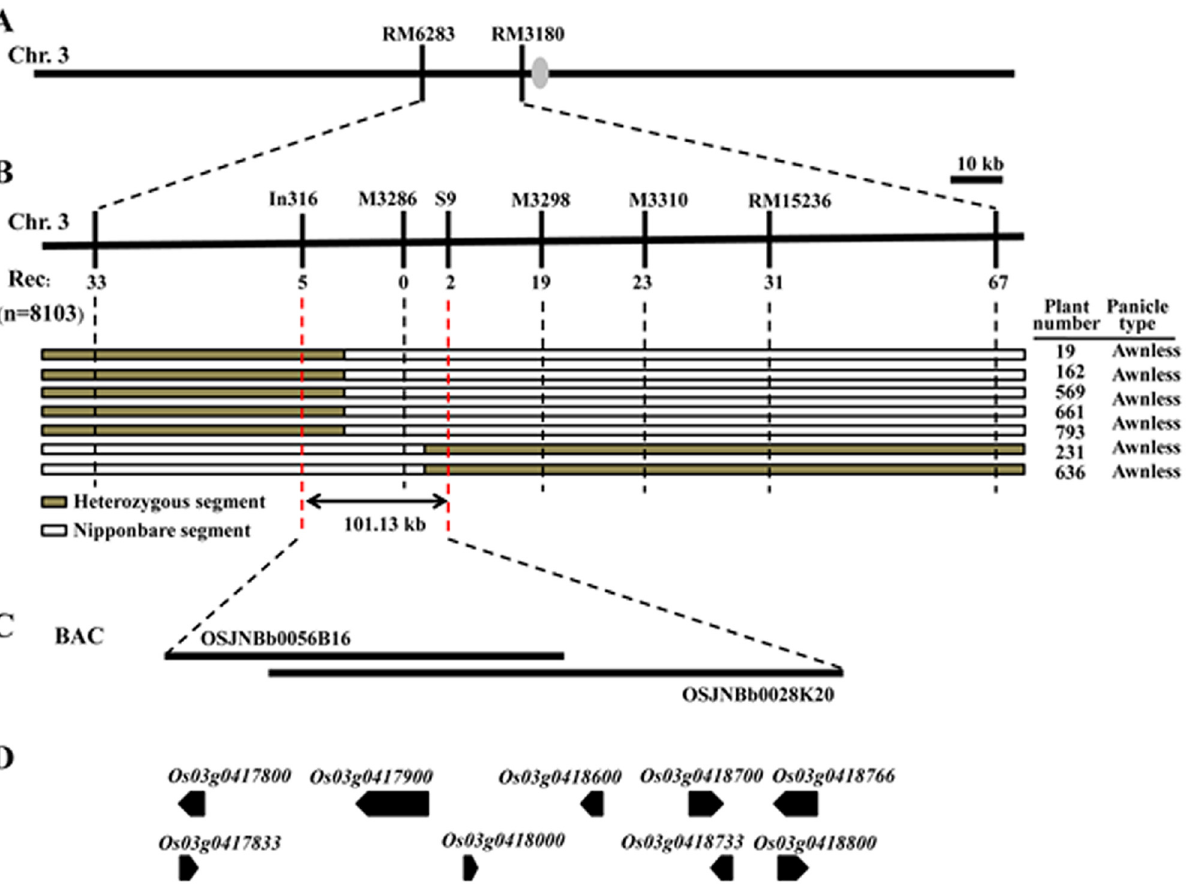
Fig 2. Fine mapping and prediction of Awn3-1 . (A) Awn3-1 was located between markers RM6283 and RM3180 on rice chromosome 3. Numbers of recombinants are shown below the position of the eight markers. Chromosomal constitution of eleven recombinants (plant numbers 19, 162, 569, 661, 793, 231 and 636) are shown with their panicle type. Grey and white bars represent chromosomal segment of heterozygous and Nipponbare, respectively. (B) Awn3-1 was fine mapped to a 101.13 kb genomic region between markers In316 and S9. (C) The Nipponbare genomic BACs (OSJNBb0056b16 and OSJNBb0028K20) in this region. (D) Gene prediction according to RAP-DB. The gray ellipse in (A) represents the